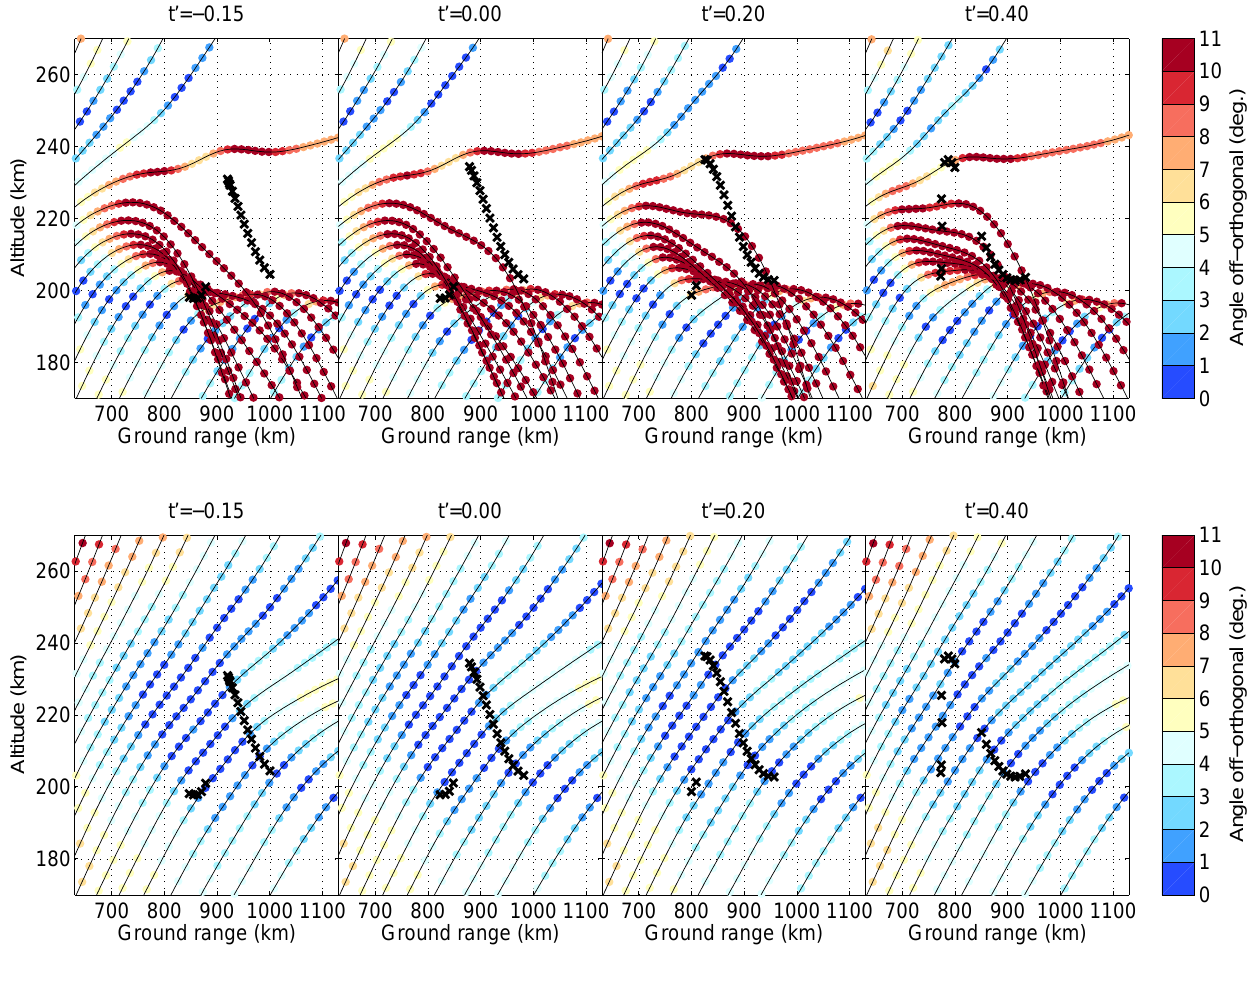
Fig. 7. As Fig. 6 but for TID